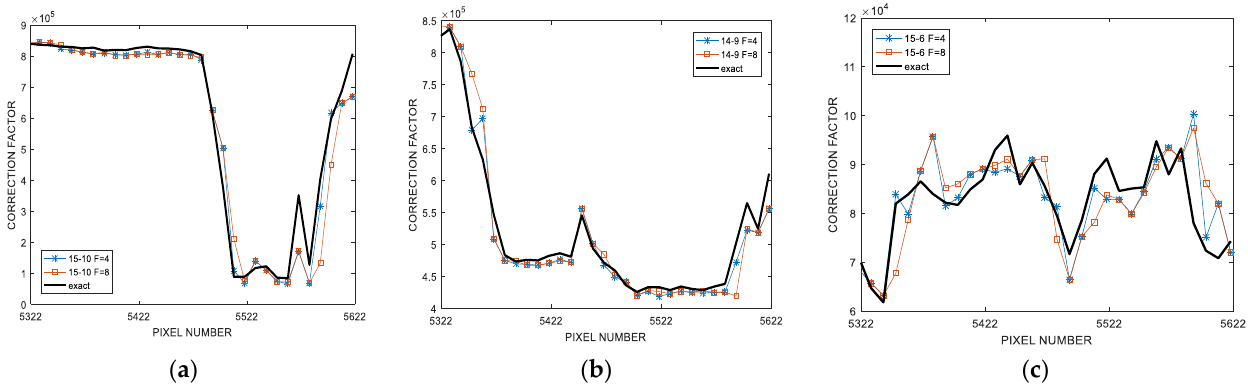
Figure 8. The correction factor updating process for a 7 × 7 convolution applied on the airplane benchmark for F = 4 and F = 8: ( a ) ( N T 1 , N T 2 ) = (15, 10), ( b ) ( N T 1 , N T 2 ) = (14, 9), ( c ) ( N T 1 , N T 2 ) = (10, 6).